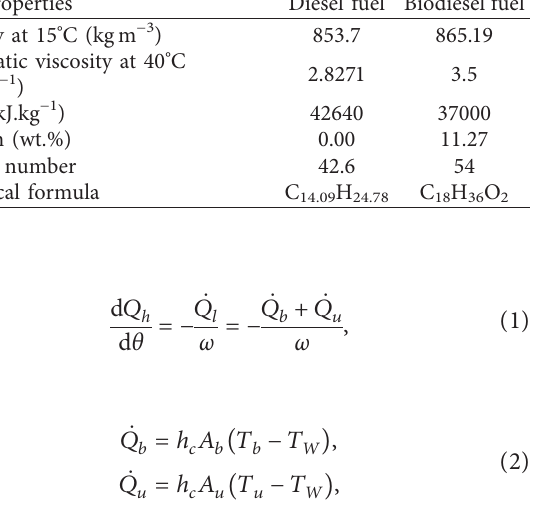
Table 2: Chemical and physical properties of test fuels. Fuel properties